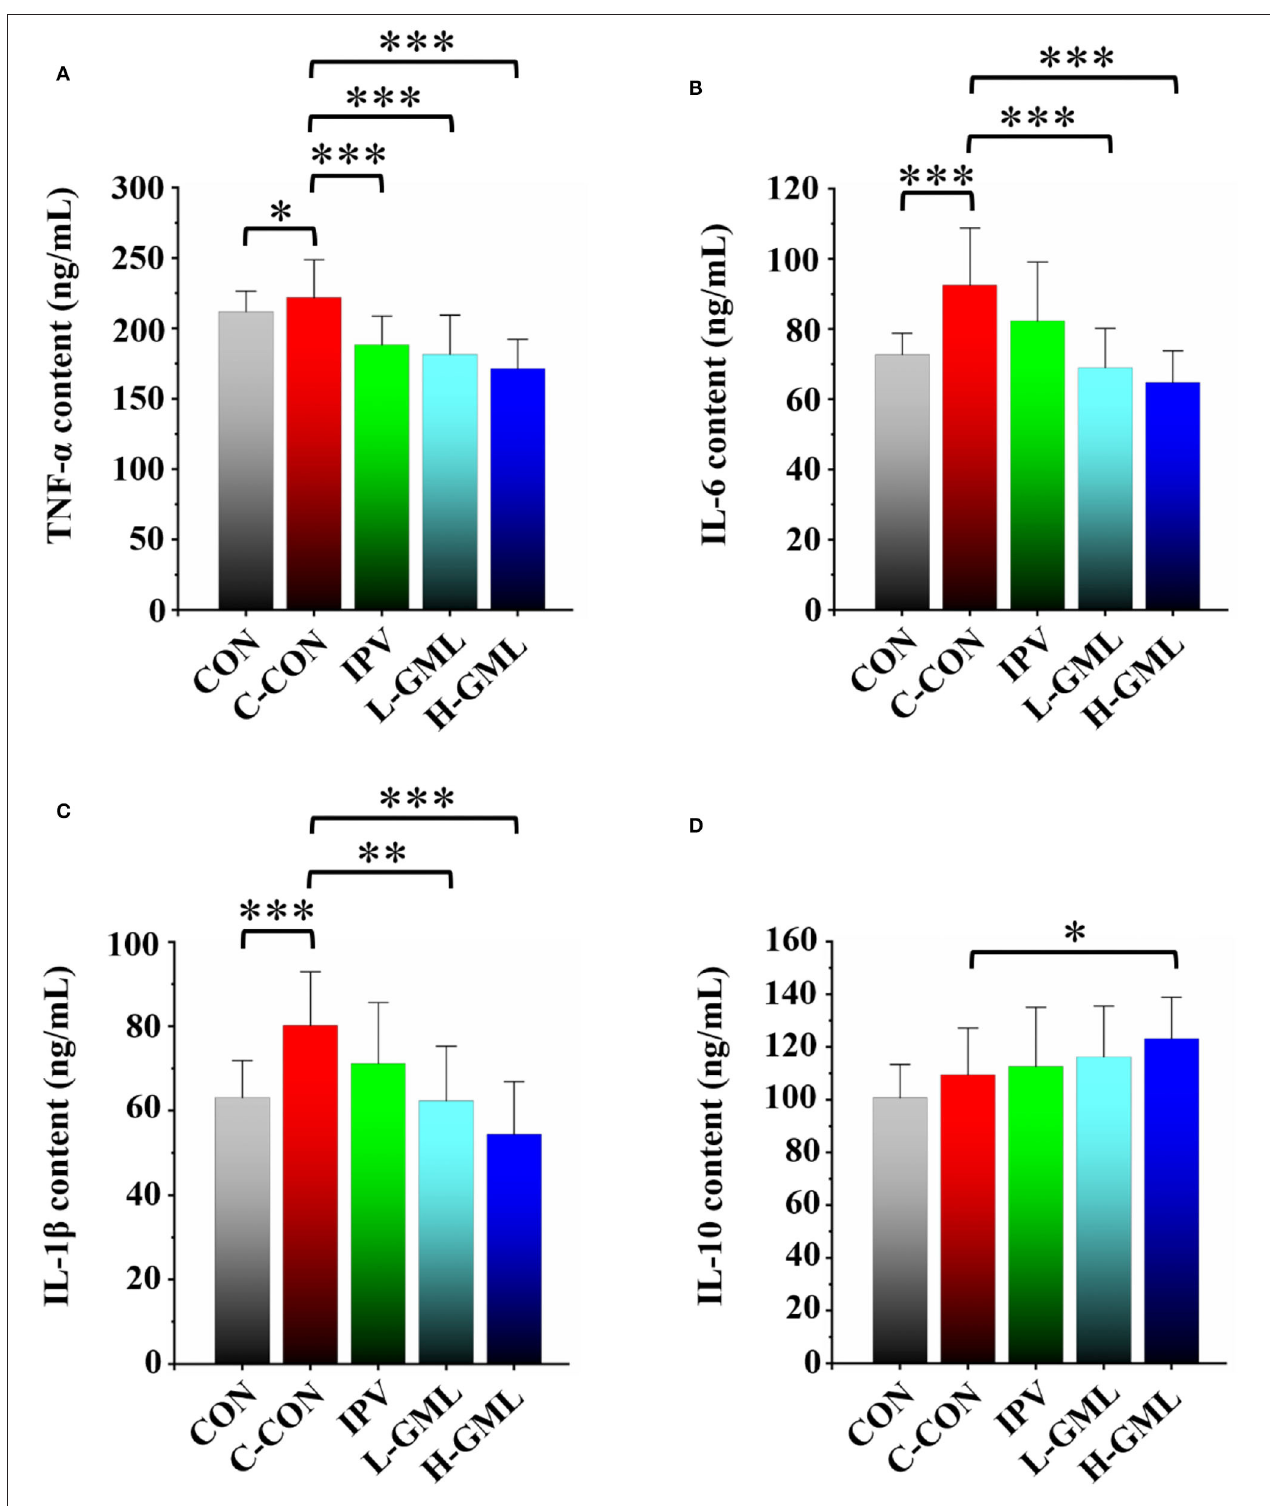
FIGURE 3 | Levels of cytokines (A) TNF- α , (B) IL-6, (C) IL-1 β , and (D) IL-10 in serum of experimental pigs. Dissimilar numbers of stars represent significant differences (*: p < 0.05, **: p < 0.01, ***: p < 0.001).